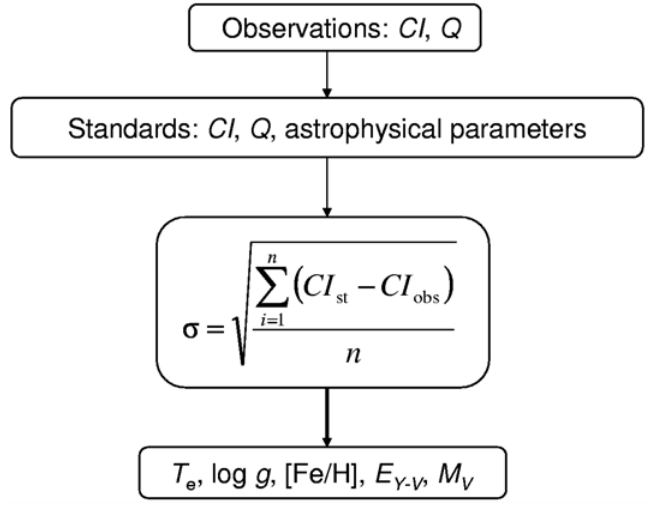
Fig. 1. The scheme of classification of metal-deficient stars in the Vilnius photometric system (the comparison